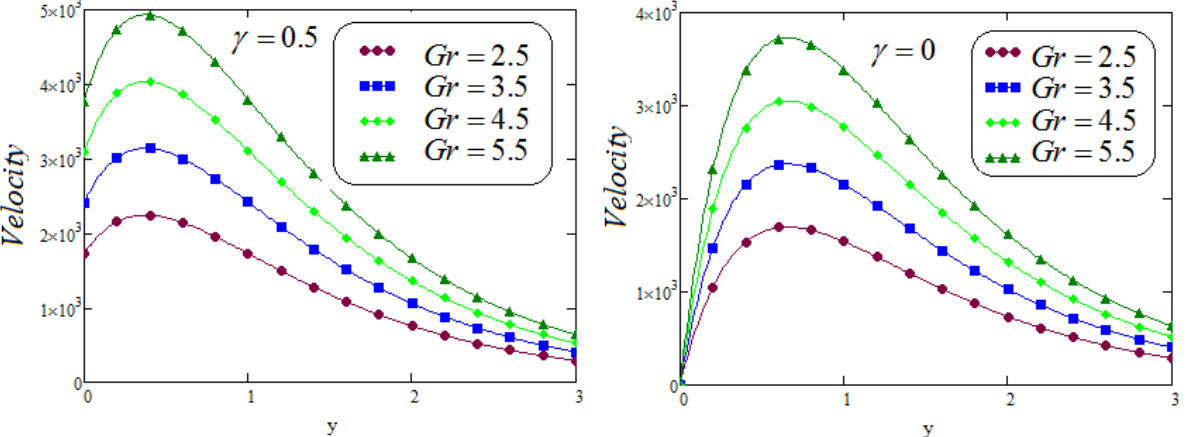
Figure 4. Velocity field under slip conditions as well as the velocity field under no-slip conditions for different Gr values when f ( t ) = e at , a = 0.25, t = 1.5, Pr = 0.71, λ 1 = 0.6, λ 2 = 0.2, M = 2.